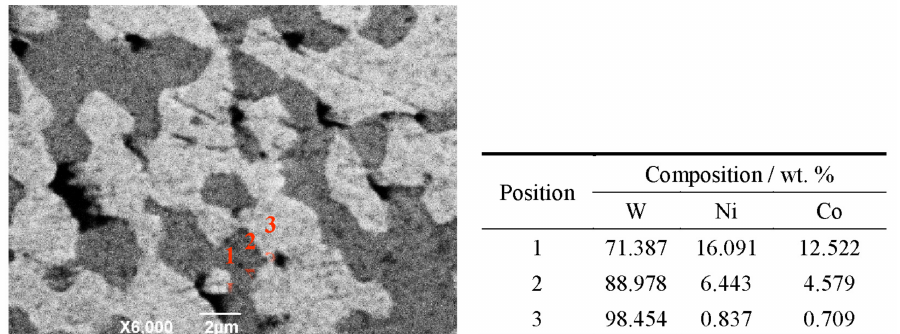
Figure 6. EDS analysis of alloy at 1450 ◦ C for 60